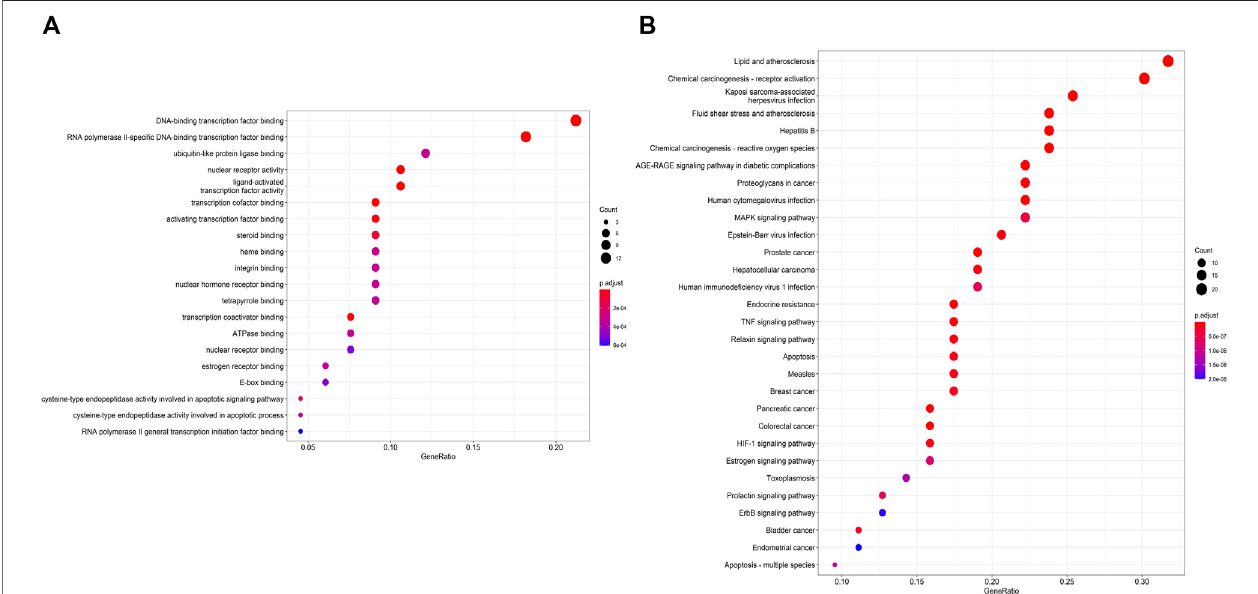
FIGURE 5 | Gene Ontology (GO) enrichment and KEGG pathways analysis for drug-disease targets (A) The top 20 signi fi cant GO enrichment analyses. The red circle represents thegene count ofeach biological process. (B) Thetop 30 signi fi cantKEGG pathways. (For interpretation ofthereferencesto colorin this fi gure legend, please refer to the Web version of this